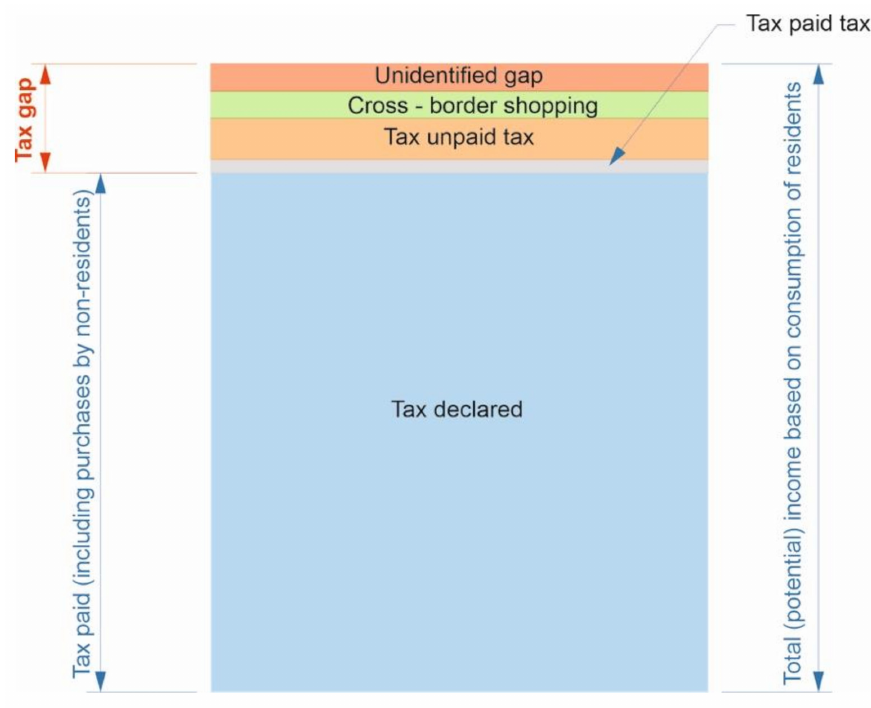
Figure 7. Scheme of the tax gap